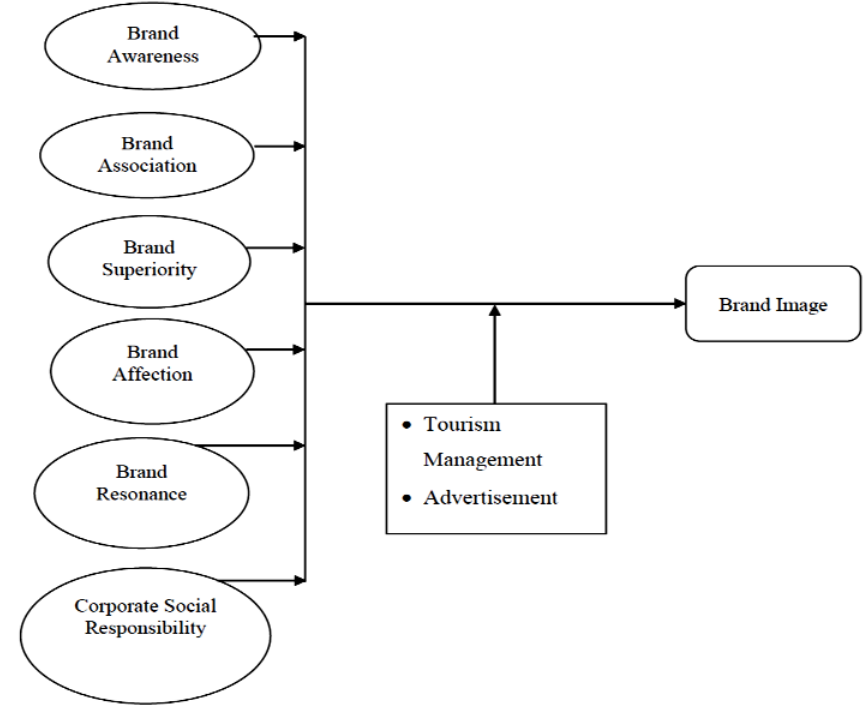
Fig. 1. A conceptual framework of brand image for tourism industry Adapted from Latif et al. (2014 &